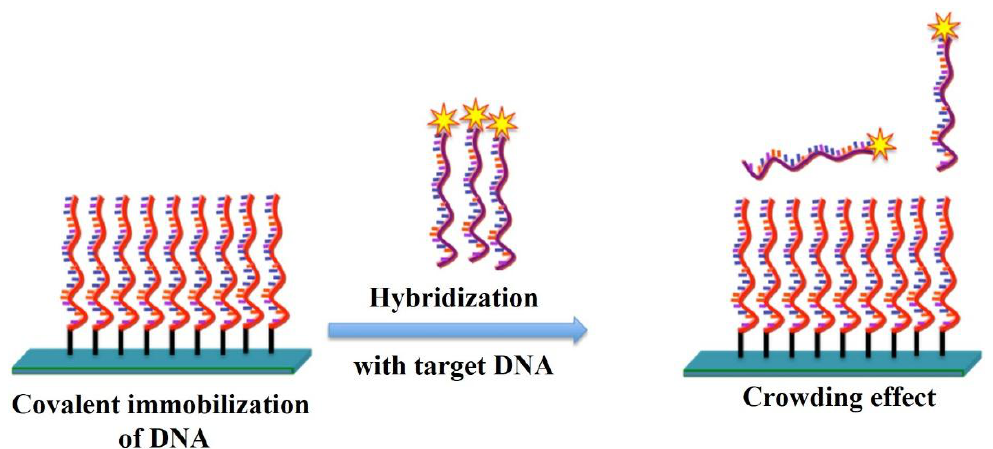
Figure 3. Crowding effect on the DNA-DNA hybridization due to the high immobilization